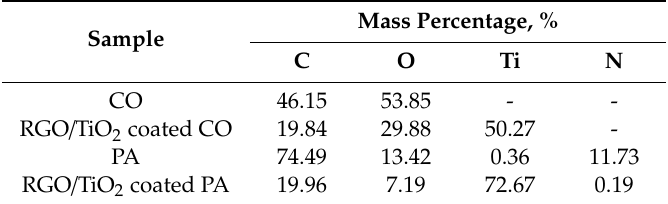
Table 1. Results of EDX